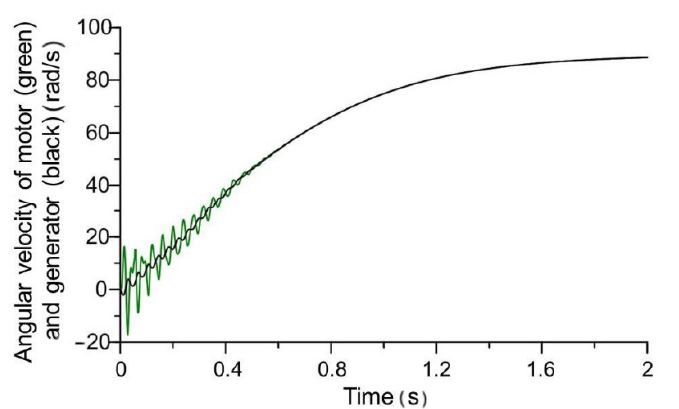
Figure 15. Results of numerical simulation of angular velocity of motor ω 1 and generator loading the drive system ω 2 .